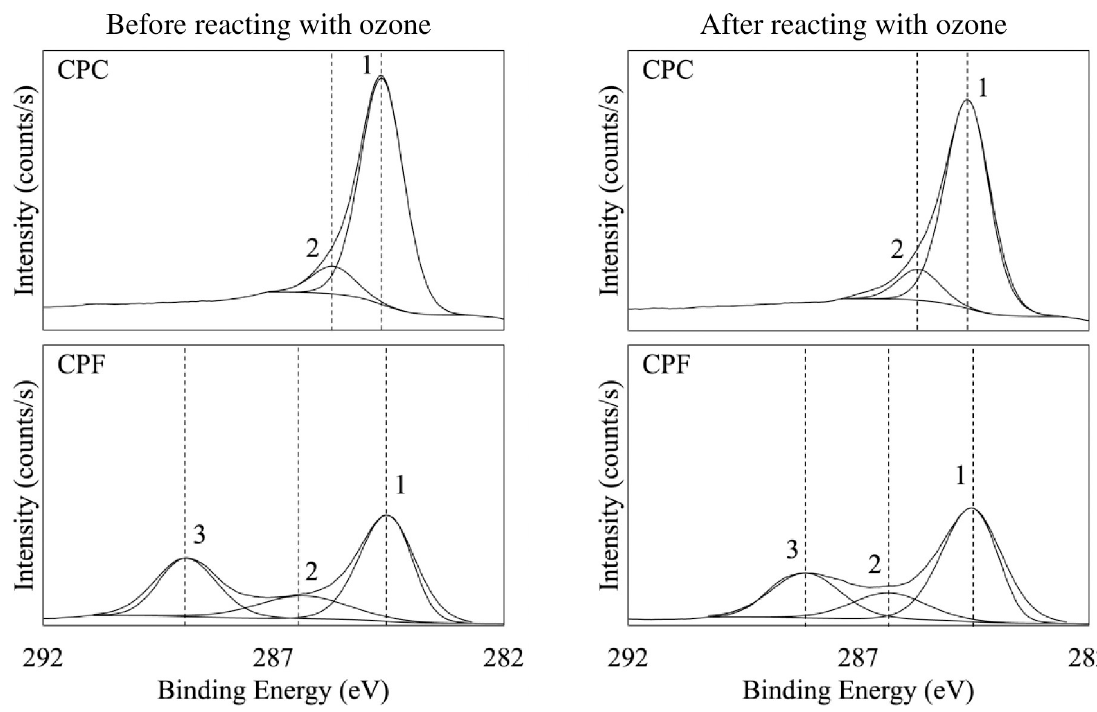
Fig 7. The XPS C1s core levels of the coffee powder before and after reacting with ozone.